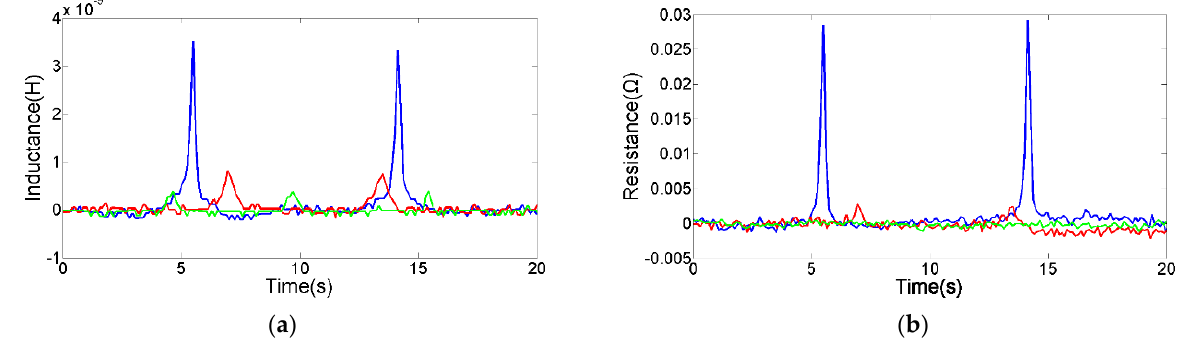
Figure 7. The detection results of 70 µ m spherical iron debris, the green line is the signal from sensing unit C, the red line is the signal from sensing unit B, the blue line is the signal from sensing unit A. ( a ) Inductance signal diagram, ( b ) resistance signal diagram.